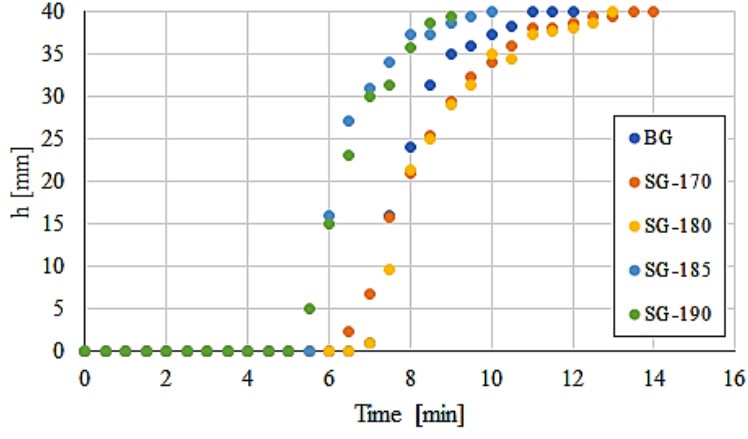
Figure 9. The setting time of the pastes based on the obtained synthetic gypsum. at different calcination temperatures